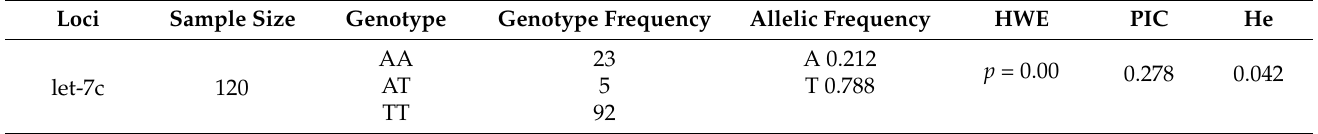
Table 1. Results of Markhoz goat population genetic analysis for identified locus.